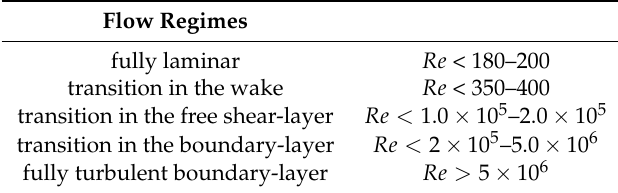
Table 2. Reynolds number and the flow regime around